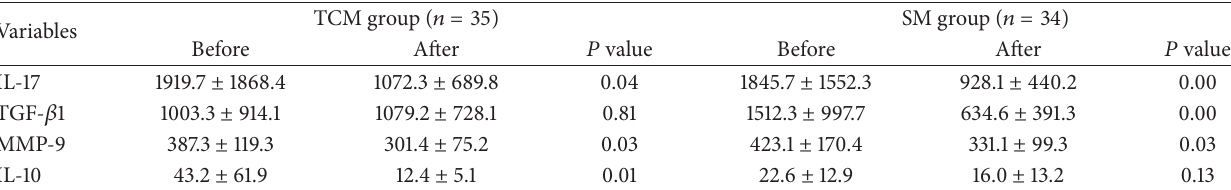
Table 5: Comparison of the peripheral blood levels of IL-10, IL-17, TGF- 𝛽 1, and MMP-9 in the TCM and SM groups before and after treatment (pg/mL, MMP-9 ng/mL, mean ± SD).